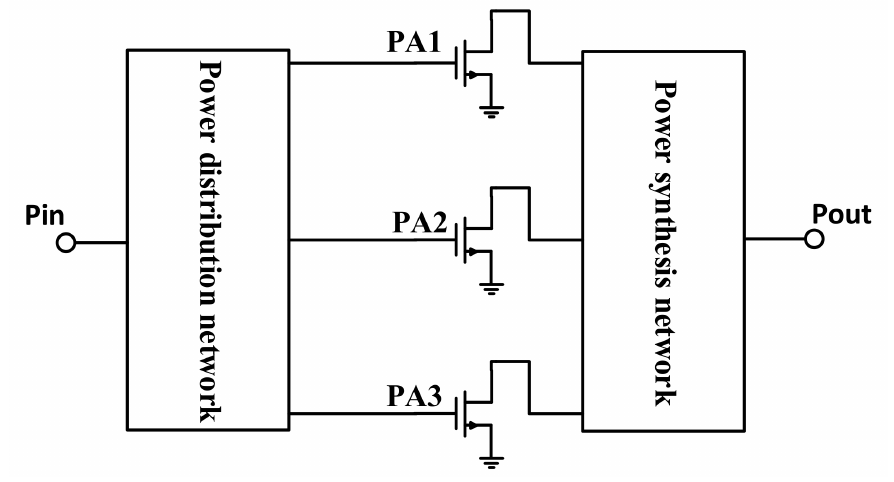
Figure 13. Three-way power amplifier circuit schematic